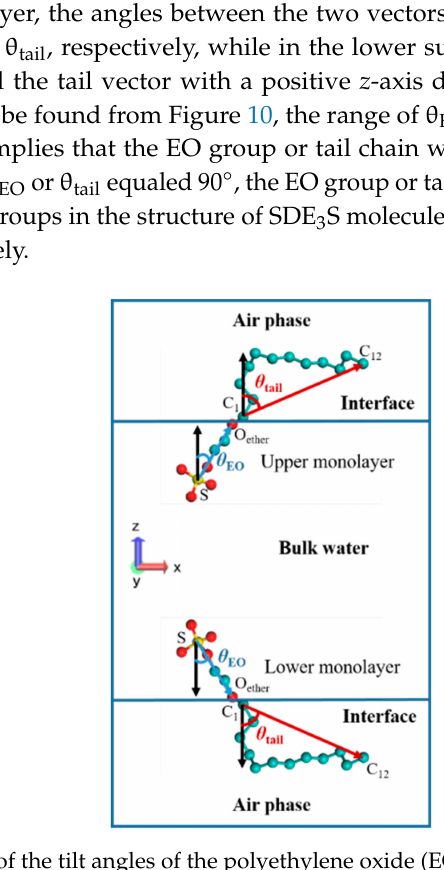
Figure 10. Definitions of the tilt angles of the polyethylene oxide (EO) group and tail chain in SDE 3 S surfactant at the air–water